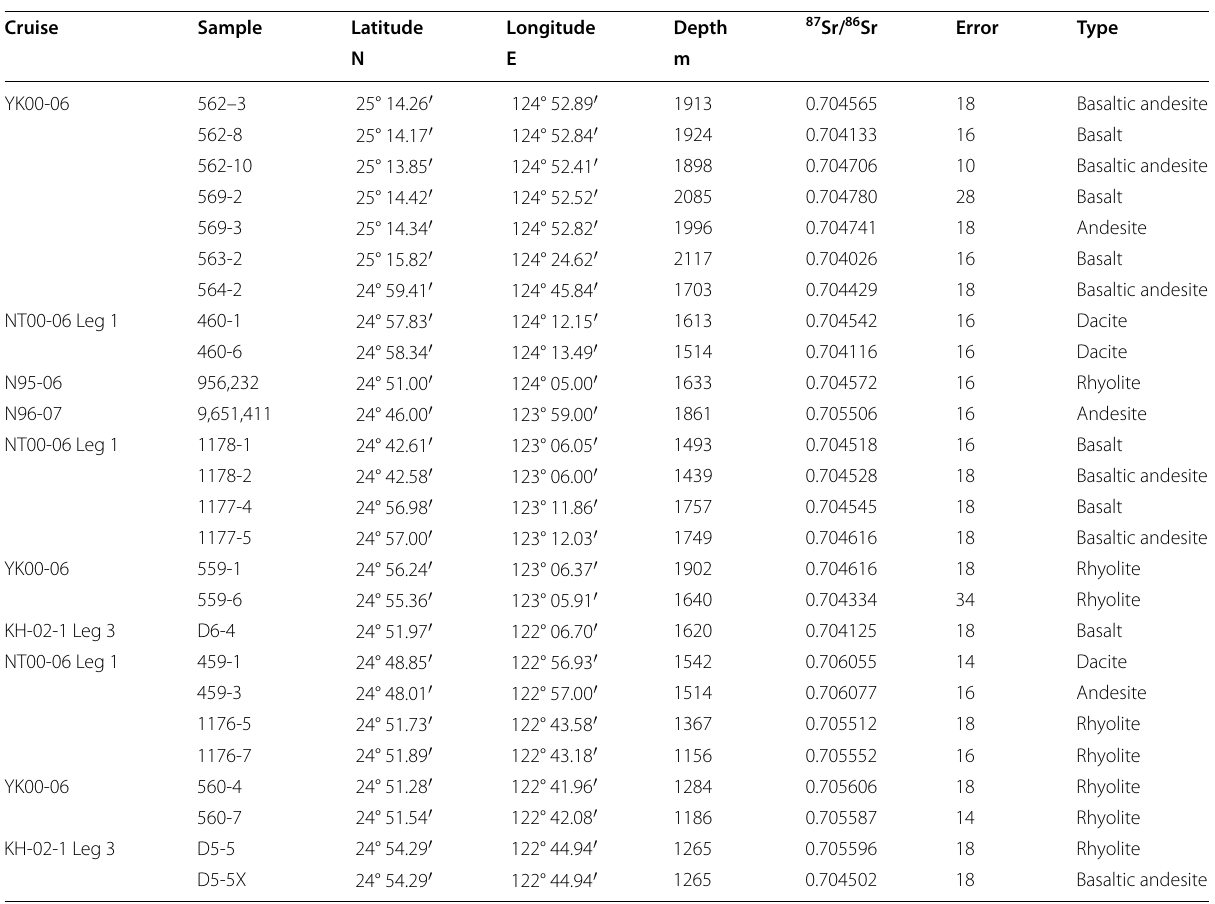
Table 3 Rock sample identities and Sr isotope ratios in this study Cruise